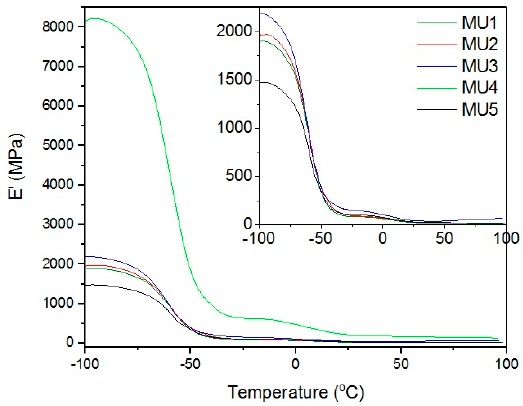
Figure 8. Relations between storage modulus E’ and temperature.